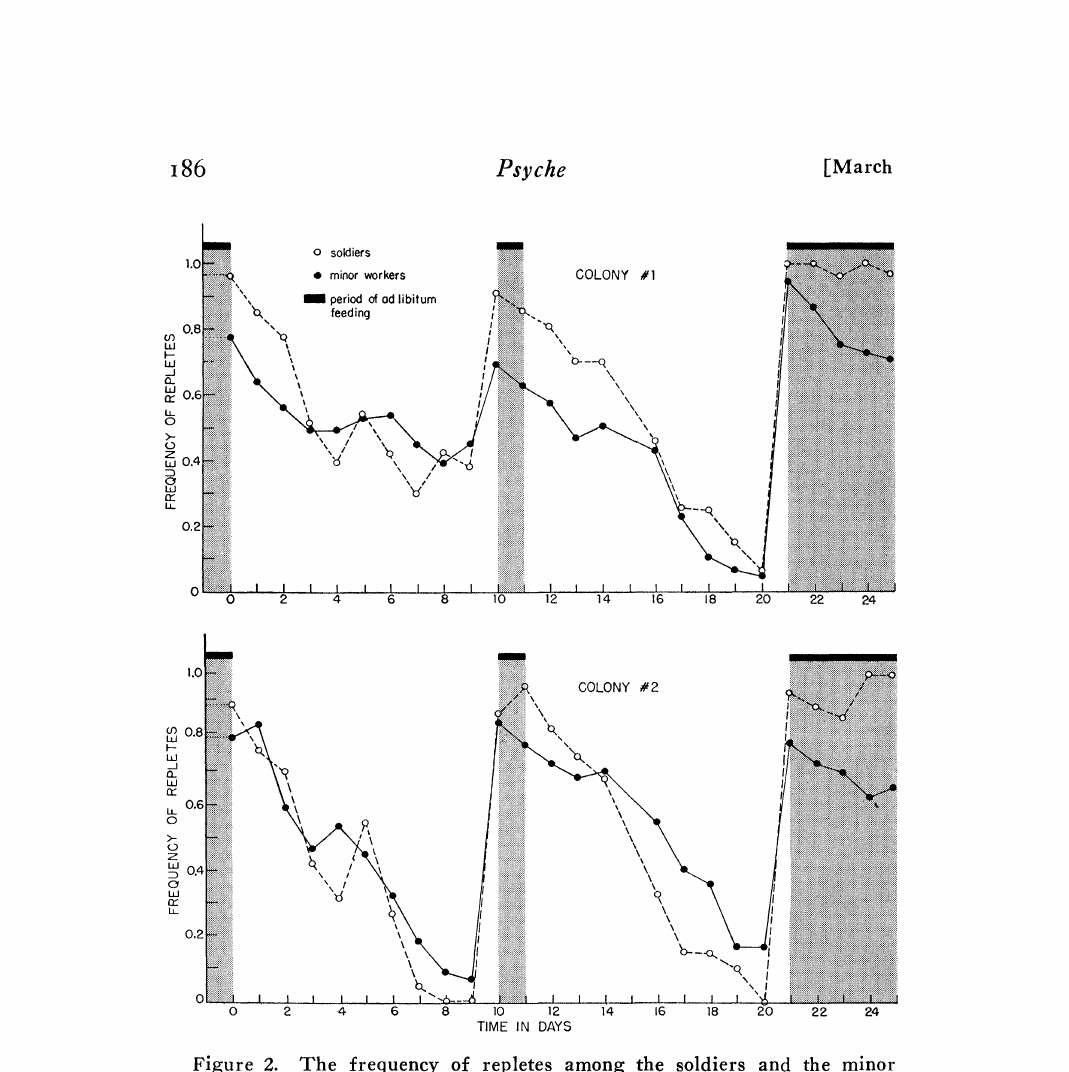
Figure 2. The frequency of repletes among the soldiers and the minor workers respectively in two colonies of Camponotus (Colobopsis) fraxini- cola. The ants were fed to satiation with sucrose solution on three occa- sions ten days apart and starved in the intervening periods. The soldier caste consistently achieved a higher level of repletion when the colony was fed but surrendered it to a greater extent when the colony was